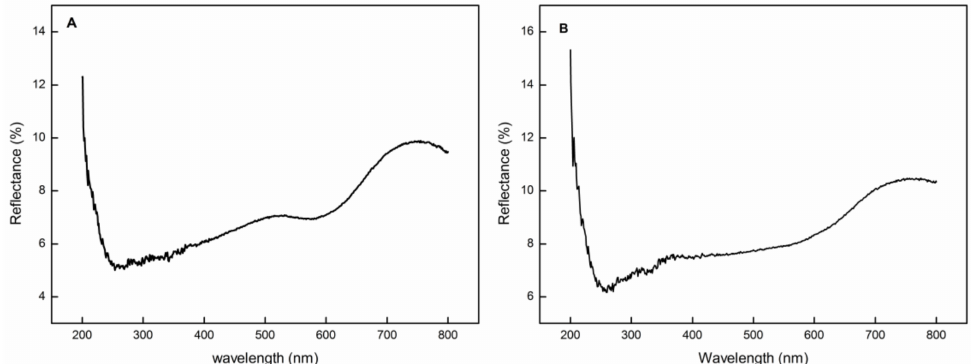
Figure 10. The average percentage of reflectance in the visible region ( A ) before steam sterilization ( B ) after 100 cycles of steam